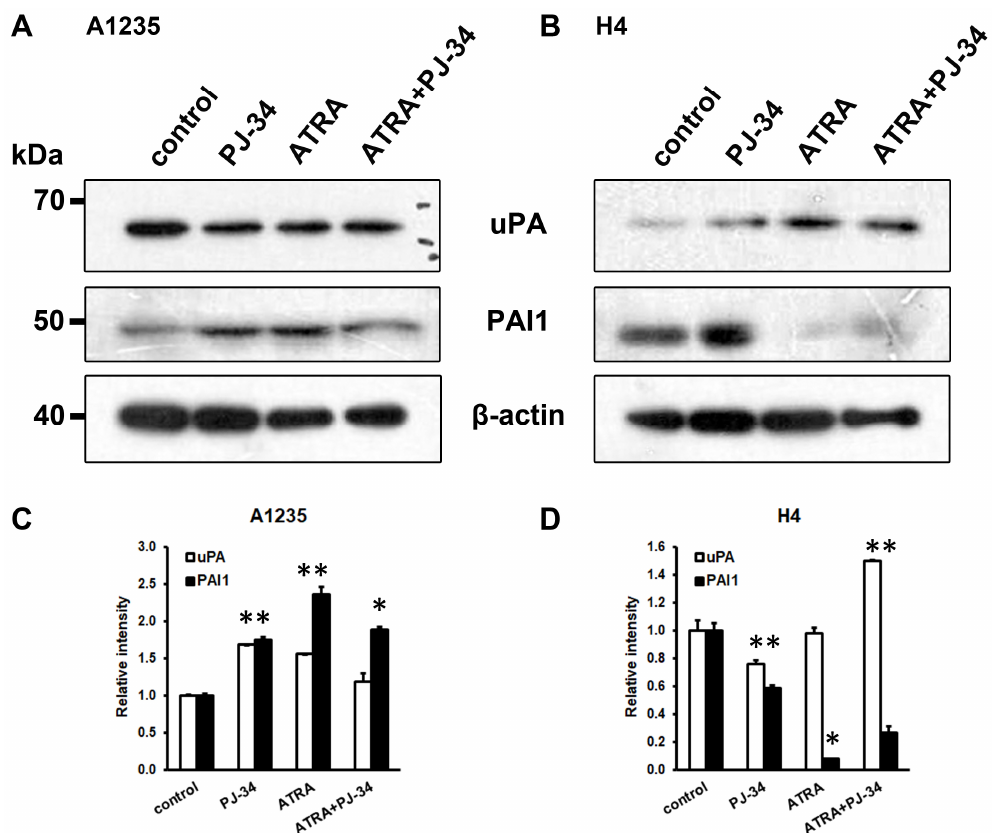
Figure 5. Western blot analysis of uPA and PAI-1 in A1235 and H4 cells after treatment with ATRA and PJ-34: After the prolonged treatment with 10 µM ATRA and 20 µM PJ-34 and their combination, the whole cell lysates were immunoblotted against indicated antibodies. ( A ) Analysis of A1235 cells; ( B ) analysis of H4 cells; and ( C , D ) densitometric analysis of western blot films of A1235 and H4 cells, respectively. PJ-34: cells treated with PARP inhibitor; ATRA: cells treated with ATRA; ATRA + PJ-34: cells treated with ATRA and the PARP inhibitor. Data are expressed as mean ± SD. * The mean values were significantly different from the control ( p < 0.05). Experiments were done two times, and representative results are presented.